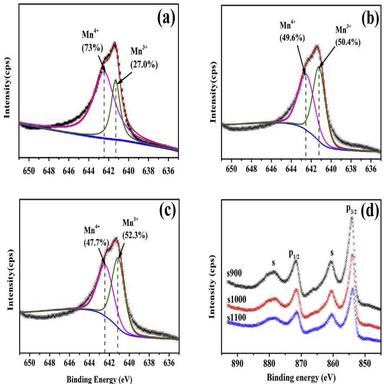
XPS Mn2p of (a) s900, (b) s1000, (c) s1100 samples; and (d) XPS Ni2P of the three samples. Dot: experimental data; line: fitted data.